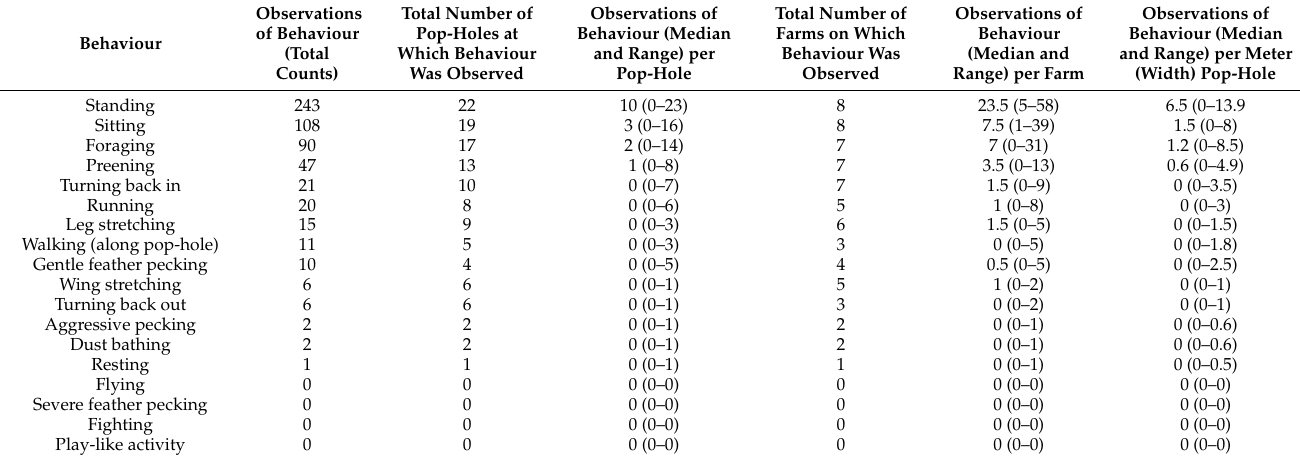
Table 5. Total and median number of behaviours observed (per pop-hole and per farm) during group behavioural observations (5 min per pop-hole) at pop-holes ( n = 23) on organic broiler farms ( n = 8) and median number of observations per meter (width)